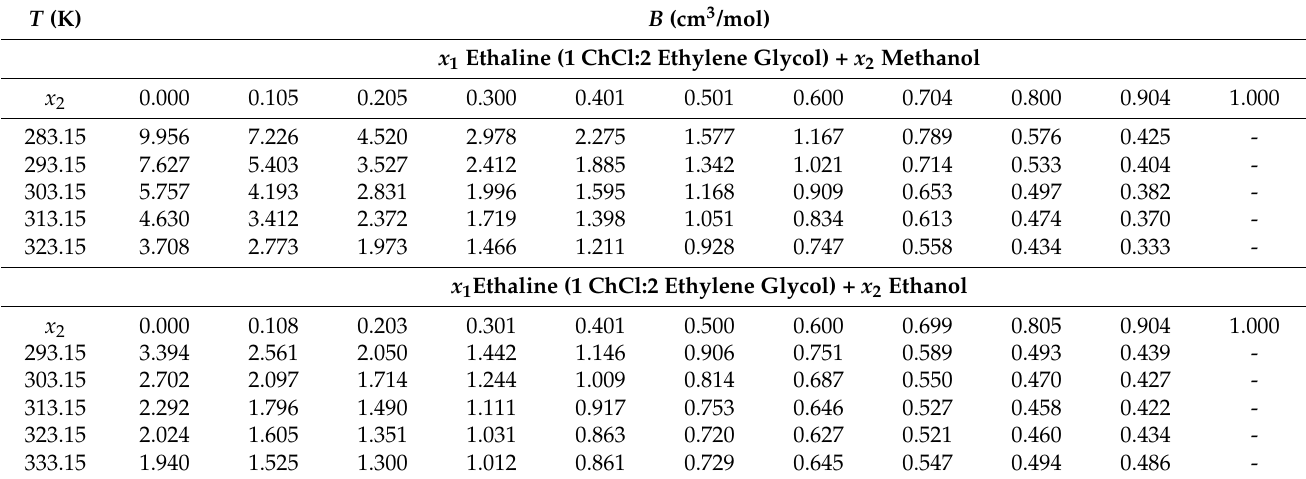
Table 6. The calculated values of the viscosity B-coefficients of the Jones–Dole model for Ethaline + methanol/ethanol mixtures at various temperatures and at a pressure of 100